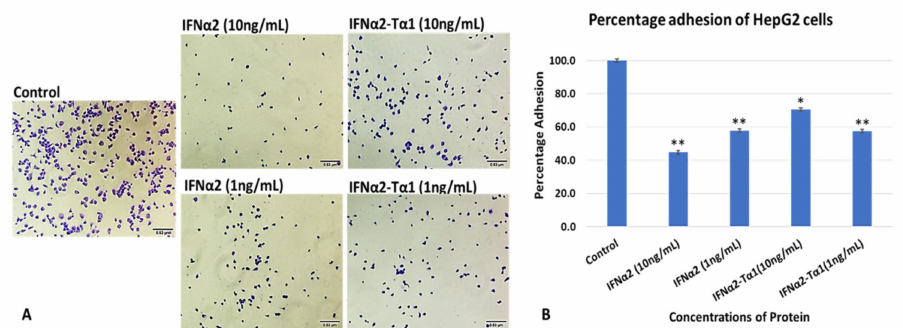
Figure 1. ( A ) Cell attachment assay of IFN α 2–T α 1 to HepG2 cells in comparison with reference IFN α 2 and control (PBS). ( B ) Crystal violet assay to determine percentage adhesion of IFN α 2–T α 1 to HepG2 cells in comparison with reference IFN α 2 at different concentrations. The experiment was performed in triplicate. “Data are represented as Mean ± SD of technical and biological replicates. For statistical analyses, One-Way ANOVA with Dunnett’s test for multiple comparison was performed using GraphPad Prism (v 7.03) ( p ≤ 0.05; ns = not significant, * p ≤ 0.05, ** p ≤